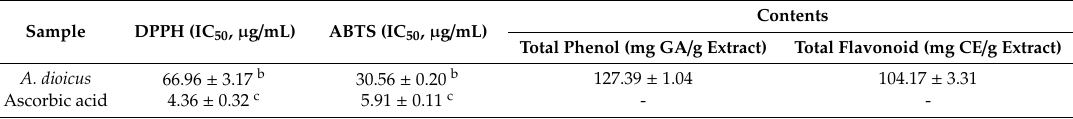
Table 2. Antioxidant activities and compound contents in A. dioicus extract.